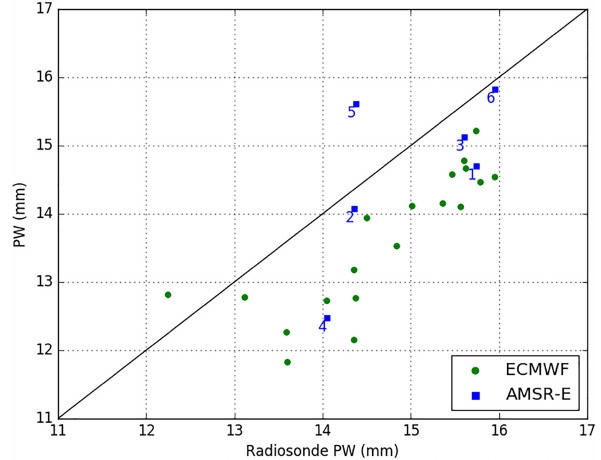
Figure 8. PW scatter plot for simulation results from different sources. All 19 RAOB cases PW are compared with the collocated ECMWF and AMSR-E PW in this figure. The x axis is the RAOB PW, and the black line is the identity line. ECMWF PW values are systematically lower (1 to 2mm) than RAOB PW and cause nega- tive biases in reconstructed profiles.